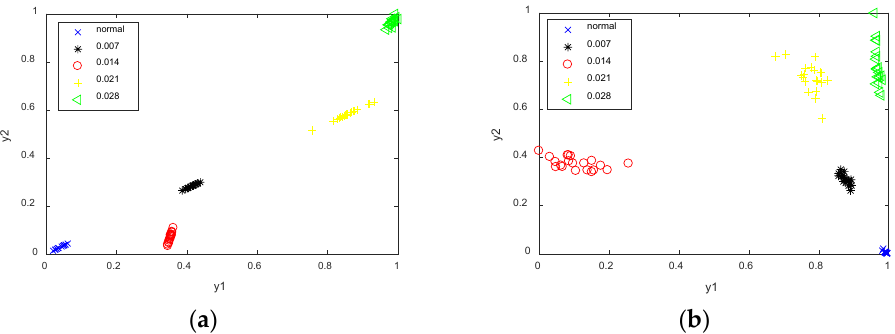
Figure 11. Comparison of dimensionality reduction effects of different methods; ( a ) LLE feature dimension reduction results; ( b ) PCA feature dimension reduction results.